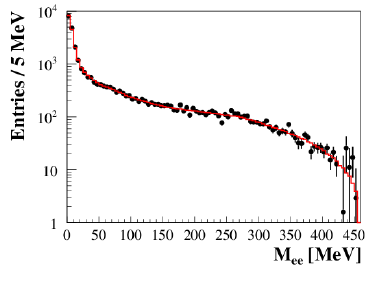
Figure 9: TFF as a function of the e + e − invariant mass of φ → η e + e